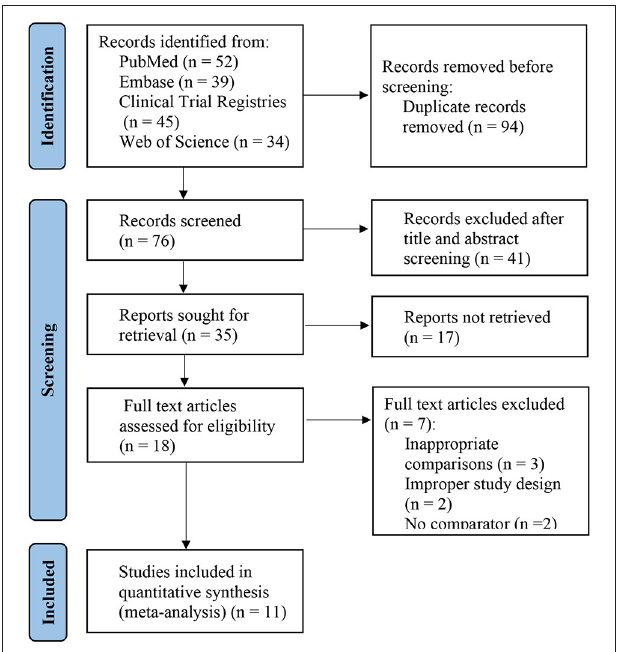
FIGURE 1 | Flow chart of the study